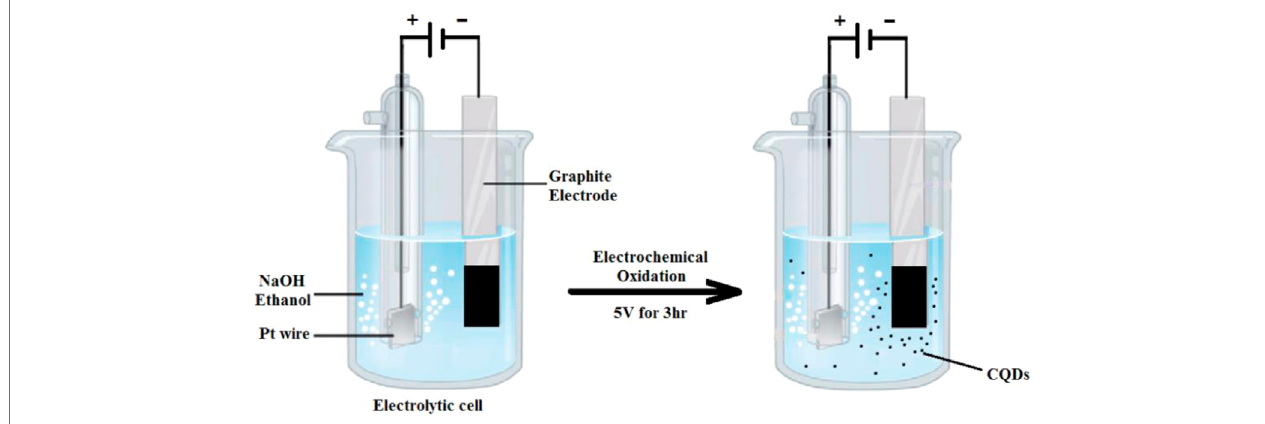
FIGURE 7 | Schematic illustration for CQD generation via an electrochemical oxidation of the graphite electrode in alkaline alcohols.